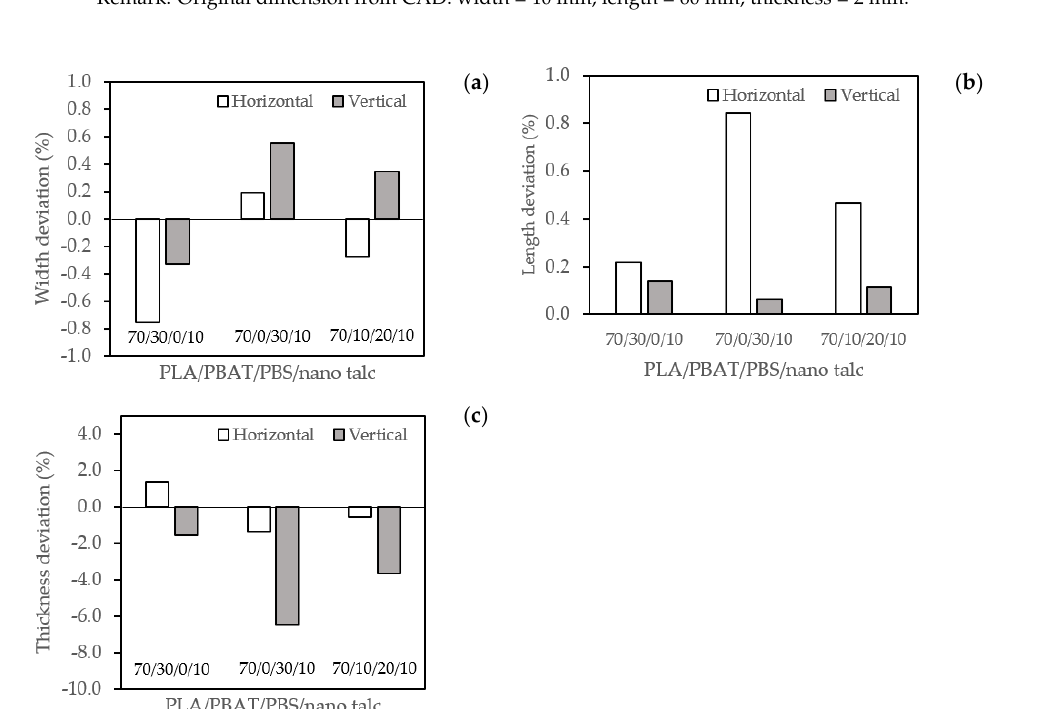
Table 9. Dimensional accuracy of PLA/PBAT/PBS/nano talc composites 3D prints.